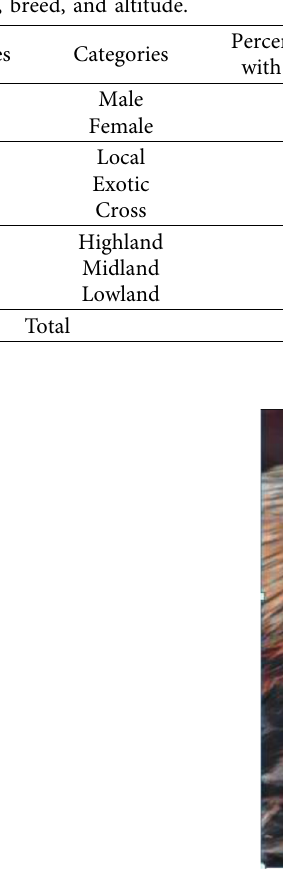
Figure 1: Avian intradermal tuberculin test positive chickens with edematous swelling on the right wattle at the site of inoculation of the avian PPD observed in this study (indicated by an arrow).